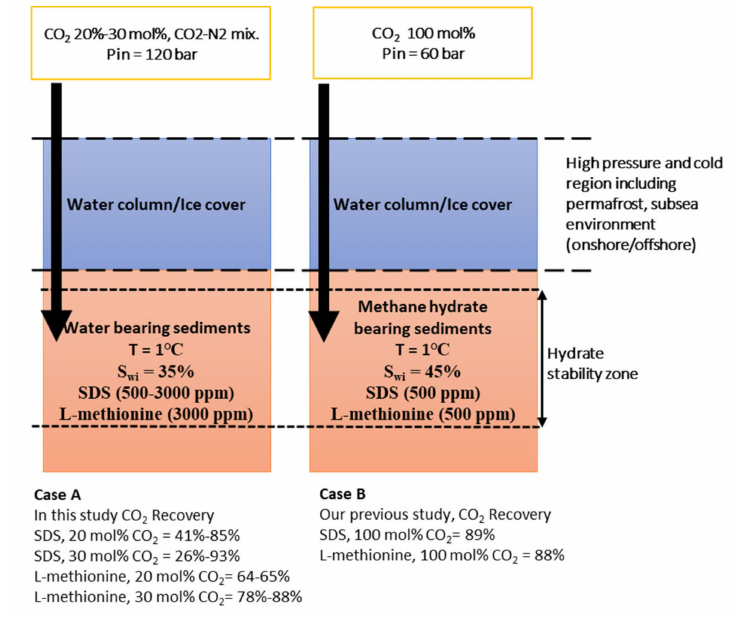
Figure 14. CO 2 recovery in two di ff erent studies. Case A, when CO 2 -rich gas is injected in porous medium and in the presence of promoter. Case B, when CO 2 is gas injected into methane hydrate